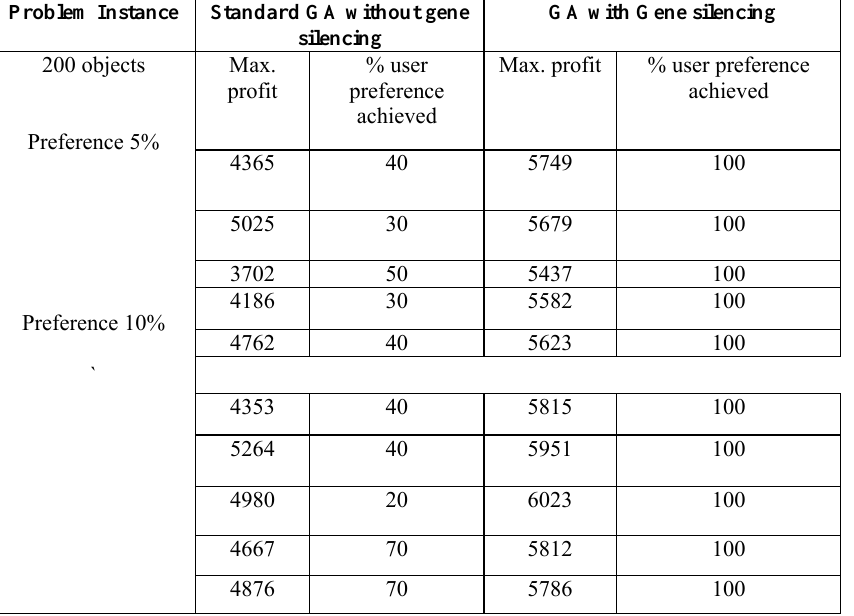
Table 2. Experiment-2 with 200 Objects and Preference of 5 % and 10%